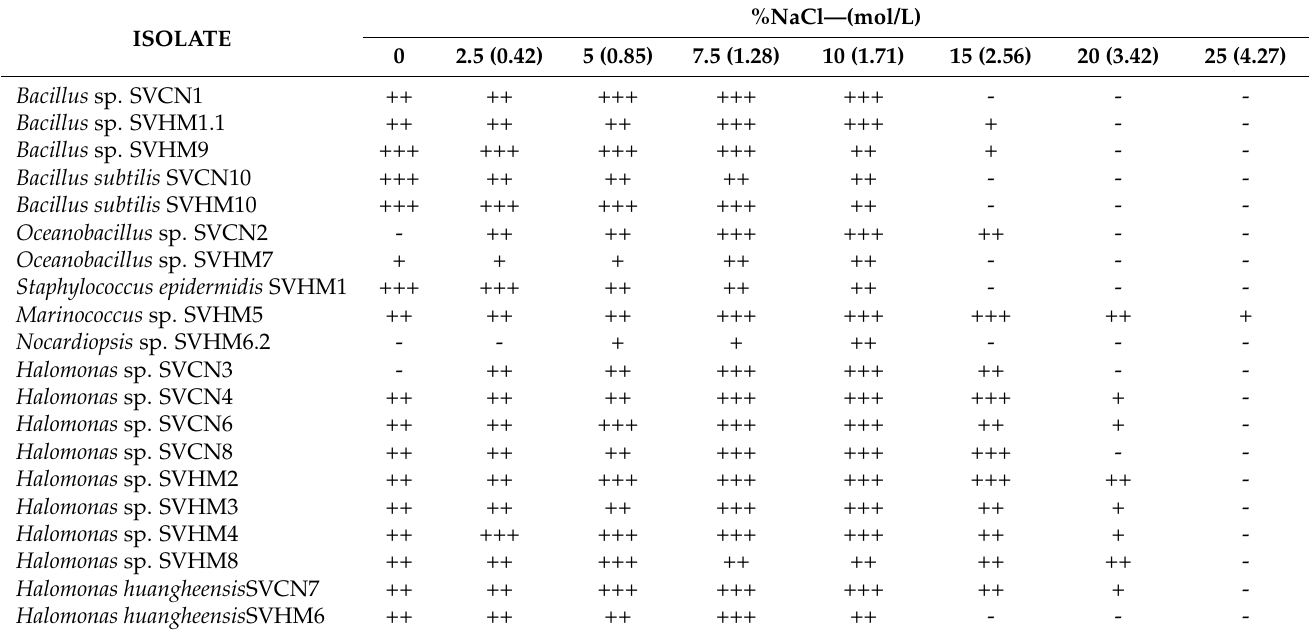
Table 3. Growth at different concentrations of